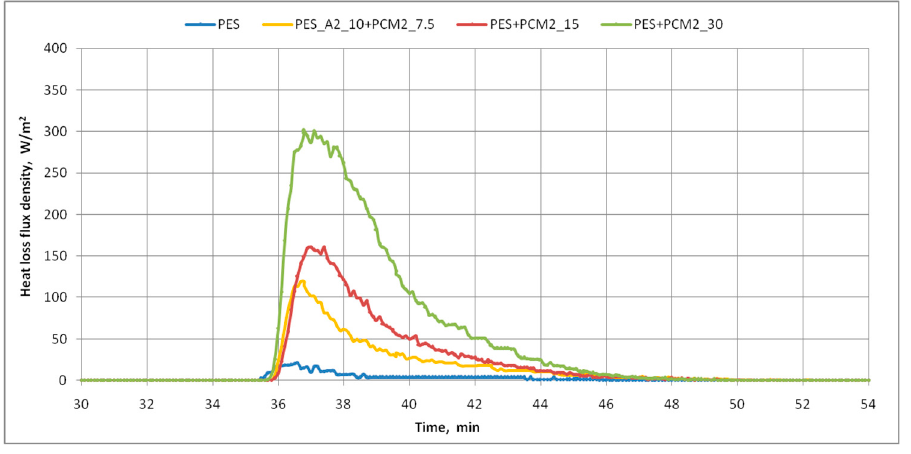
Figure 9. The course of changes in the mean values of the surface temperature of the measuring plate of the skin model (under isothermal conditions).